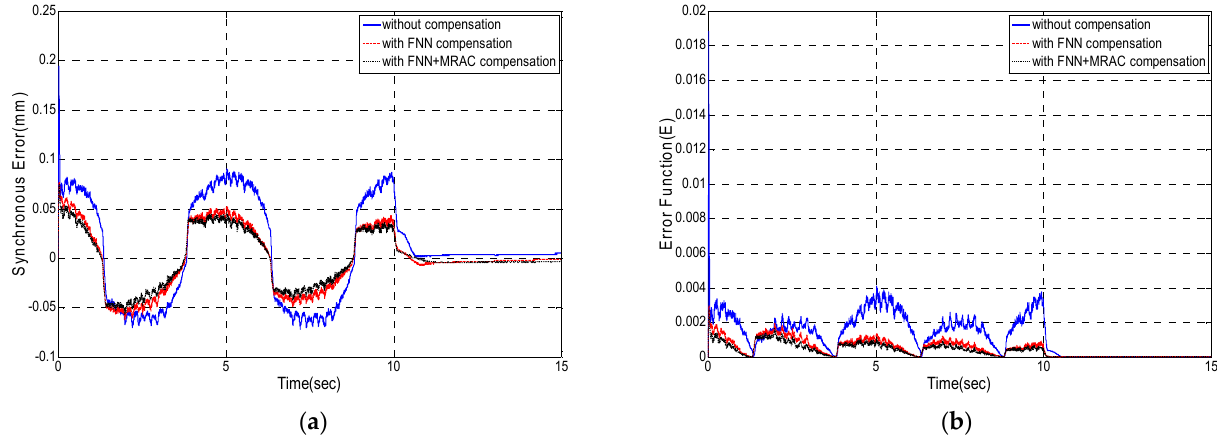
Figure 15. ( a ) The synchronous error under low-frequency commands; ( b ) the cost function under low-frequency commands.